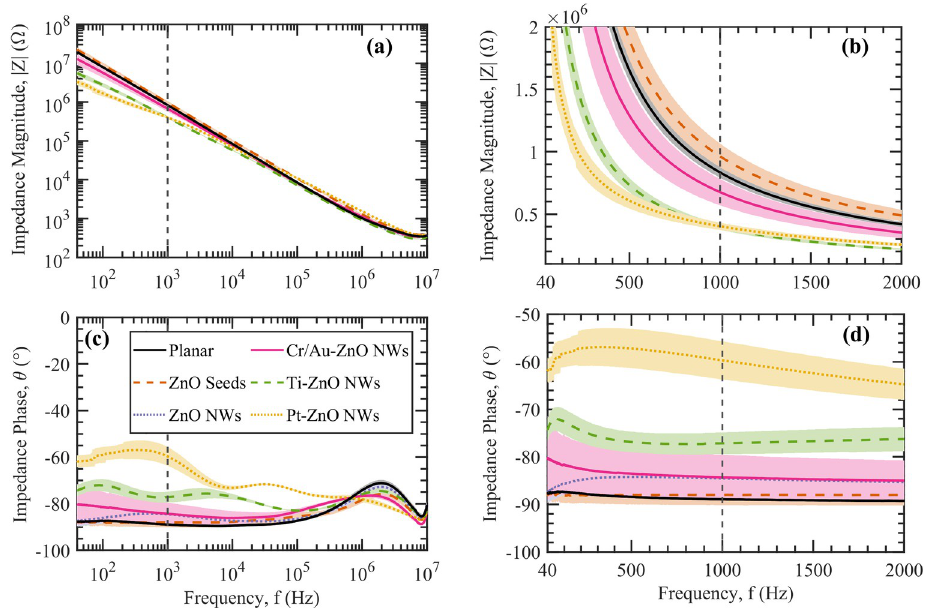
Fig 8. Electrochemical impedance spectroscopy (EIS) of microelectrodes with metal encapsulated ZnO NWs. (a, b) Impedance magnitude and (c, d) impedance phase are plotted vs frequency with dashed lines indicating the frequency of 1 kHz. (b) and (d) show the electrochemical impedance magnitude and phase, respectively for the frequency range of 40 Hz to 2 kHz in linear scale. Error shades represent one standard deviation (N � 20